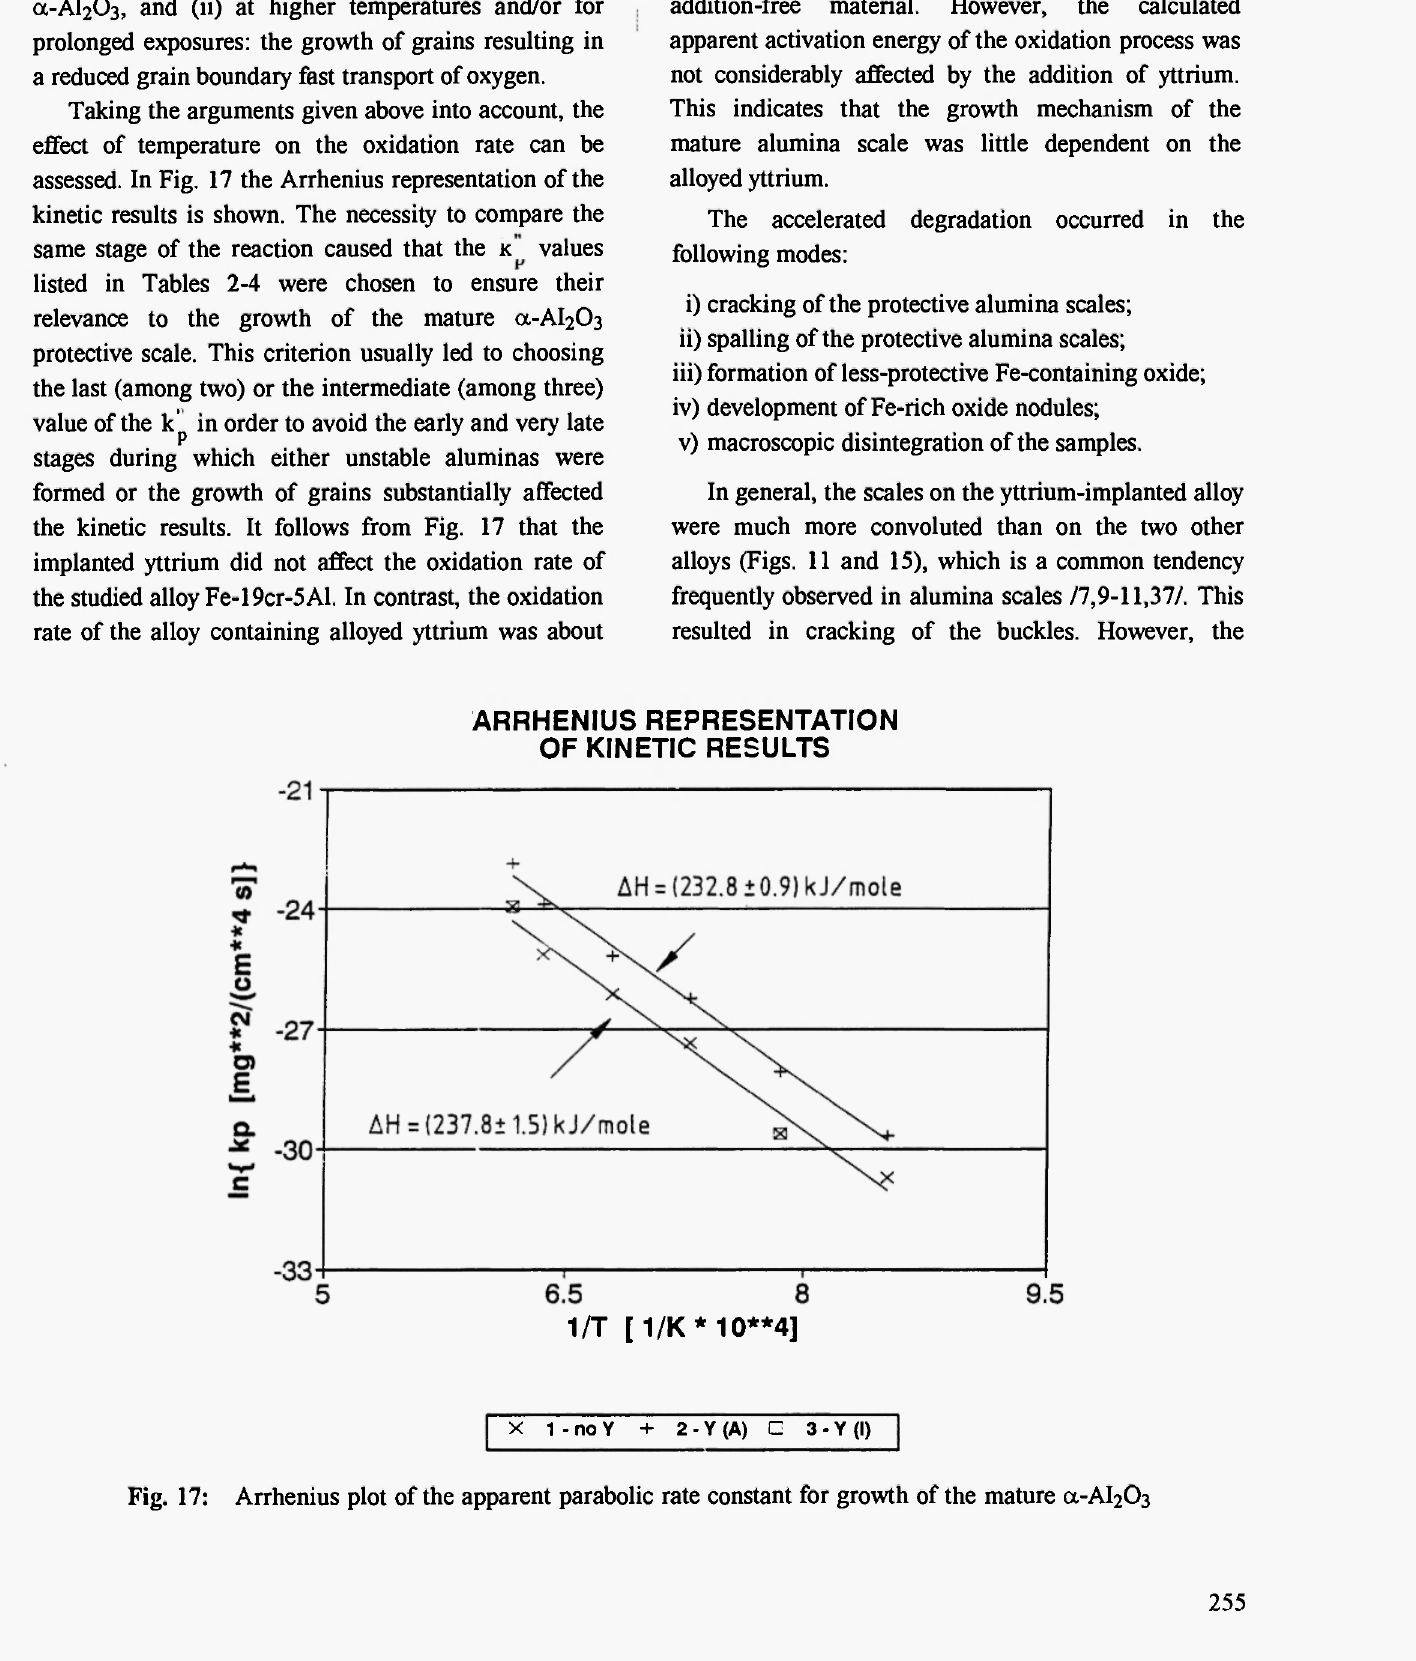
Fig. 17: Arrhenius plot of the apparent parabolic rate constant for growth of the mature